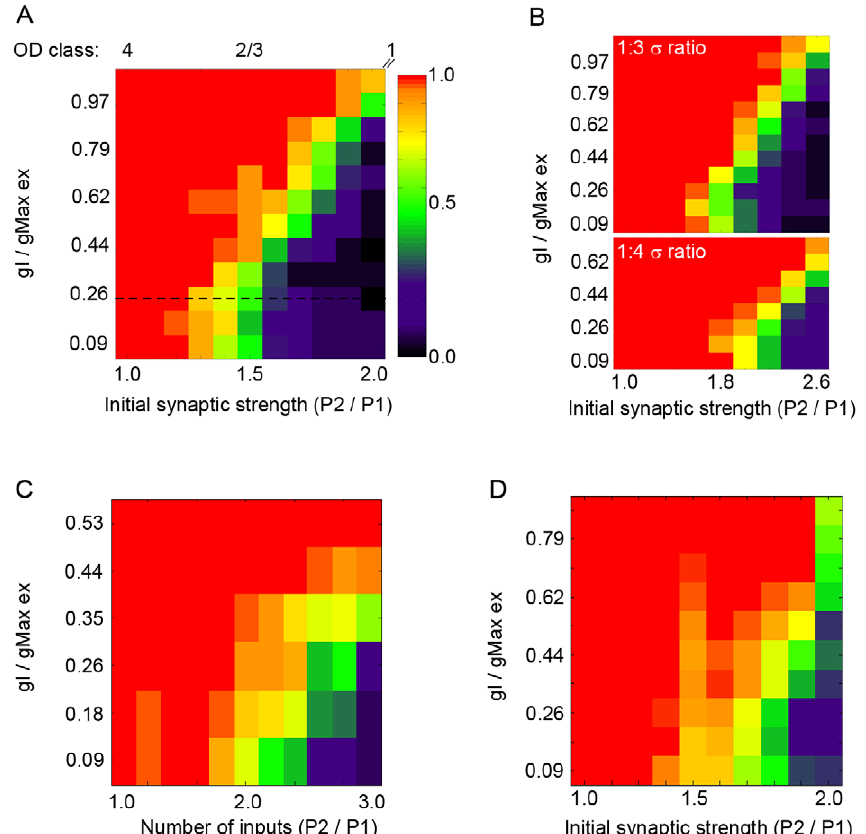
Figure 4. The level of inhibition determines whether temporal coherence or synaptic drive controls postsynaptic spike times in the IAF model. Color shades indicate fraction of trials in which P1 out-competed P2: red=100%, black=0%. (A) At the lowest amplitude of inhibition, the range of initial synaptic strength ratios (ISS P2/P1 ) over which the temporally more coherent P1 pathway can compete with the stronger but less coherent P2 pathway is narrow (between 1–1.2) and restricted to a subset of OD class 4 cells. At a high level of inhibition, the range of ISS P2/P1 ratios over which P1 successfully out-competed P2 above chance level (0.5) is extended to include the full spectrum of OD class 4 and the majority of class 2/3 cells. In this case, pathway temporal coherence ( s 2 1 ) between the two pathways was set to a ratio of 1:2 (P1:P2). (B) The influence of inhibition holds for a range of temporal coherence pathway ratios. (C) Increased inhibition had a similar influence when contralateral bias was implemented as a difference in number of synaptic inputs, rather than initial synaptic strength, P2/P1 ratios ranging from 1 to 3 were tested. (D) The ability of increasing inhibition to provide a competitive advantage to P1 over P2 is maintained in an implementation of weight-dependent STDP. In this case, the amount of potentiation for a given LTP event was inversely related to synaptic strength A + * (1- a ), see Methods for more